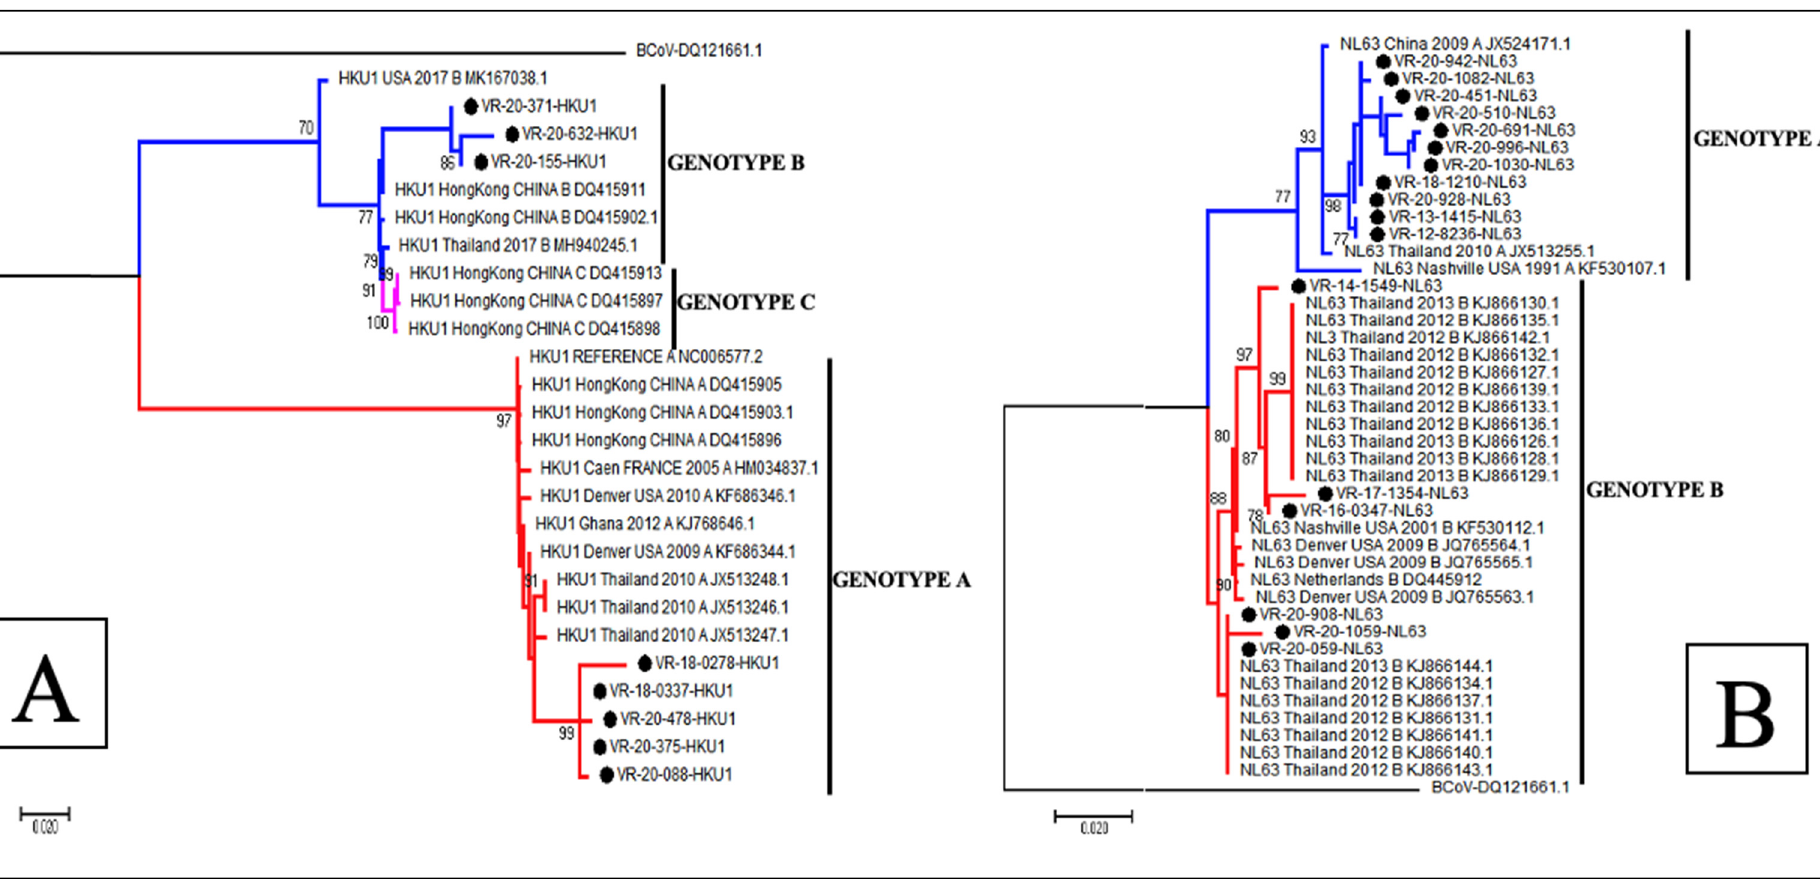
Figure 4. Phylogenetic analyses of HCoV-HKU1 ( A ) and HCoV-NL63 ( B ) strains detected in patients with ILI/SARI, between 2012 to 2020, in Senegal. The phylogenetic trees are based on the nucleotide sequences of the spike protein gene generated using the maximum likelihood tree with the Tamura–Nei evolutionary model, as implemented in MEGA 7 software. One thousand bootstrap replicates were performed to determine the consensus tree presented in this figure, and support for nodes present in greater than 70% of the trees are annotated. Senegalese strains are represented in black dots.